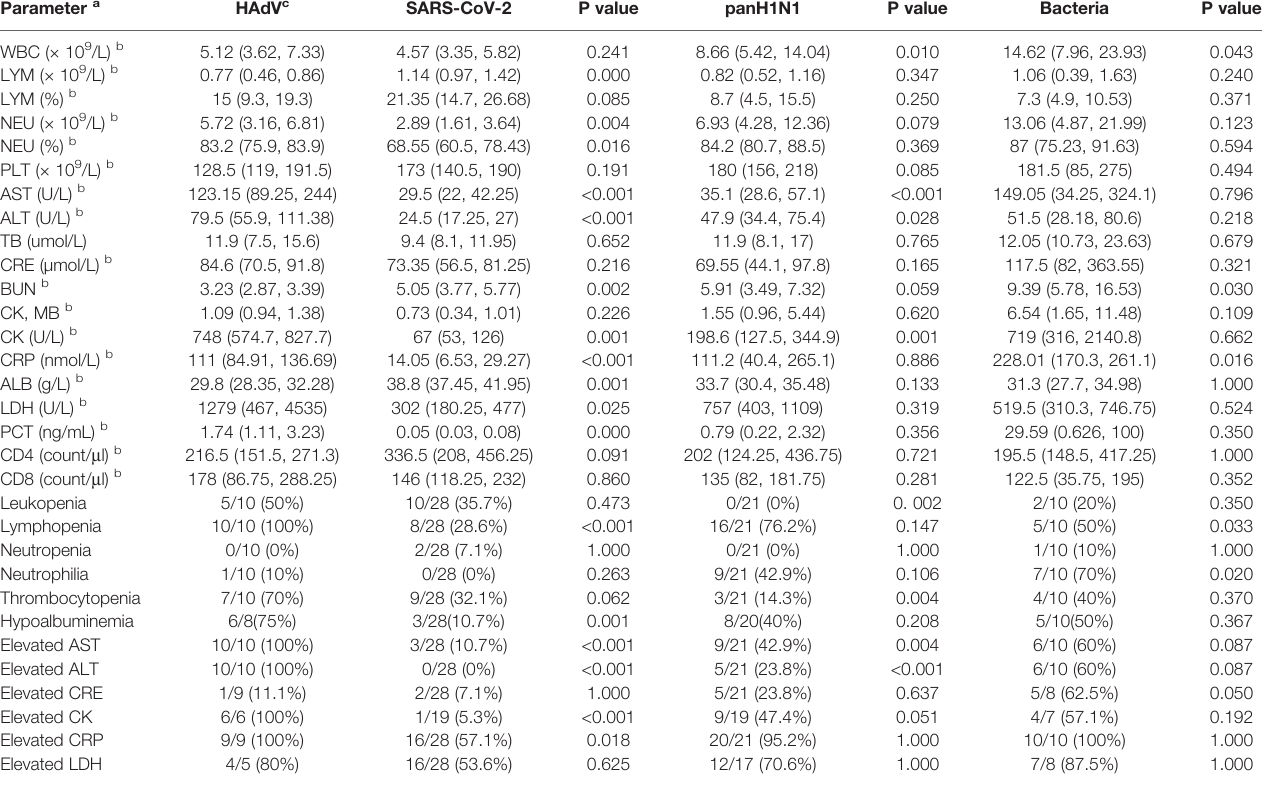
TABLE 1 | Laboratory results of hospitalized patients complicated with ARDS caused by HAdV, SARS-CoV-2, panH1N1 and bacteria. Parameter a HAdV c SARS-CoV-2 P value panH1N1 P value Bacteria P value WBC (× 10 9 /L)